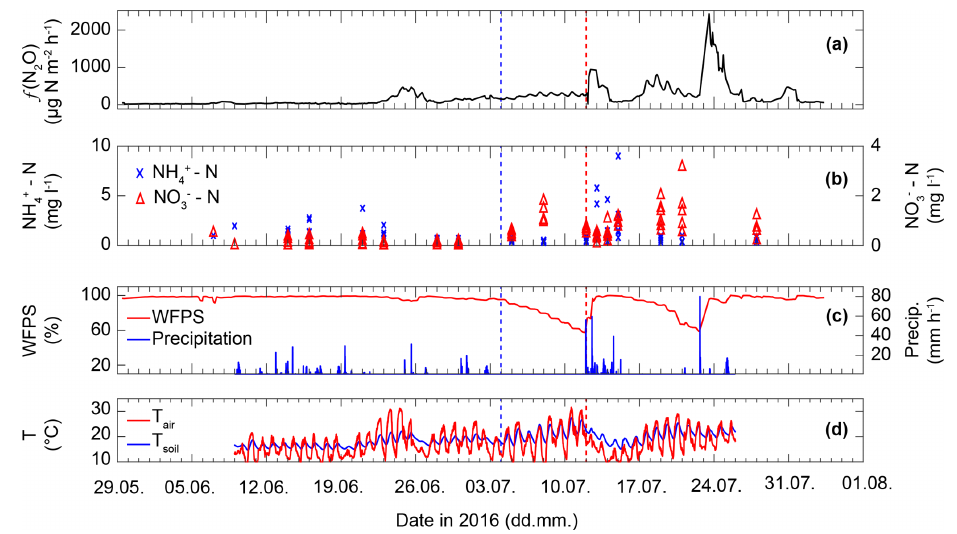
Figure 3. (a) Average N 2 O flux ( f (N 2 O)) as measured by five replicate flux chambers coupled to a GC-ECD. (b) Concentration of NH + and NO − -N. Up to eight nodes across the De-Fen site were sampled twice per week, except in the week of fertilization, when sampling 3 frequency was increased. Therefore, variability within a sampled day refers to spatial variability across the De-Fen site on the given day. (c) Observed WFPS (red) and precipitation (blue). (d) Observed ambient (2ma.g.l.) and soil (2–6cm below ground) temperature. The blue dashed line indicates a cutting event and the red line indicates manure